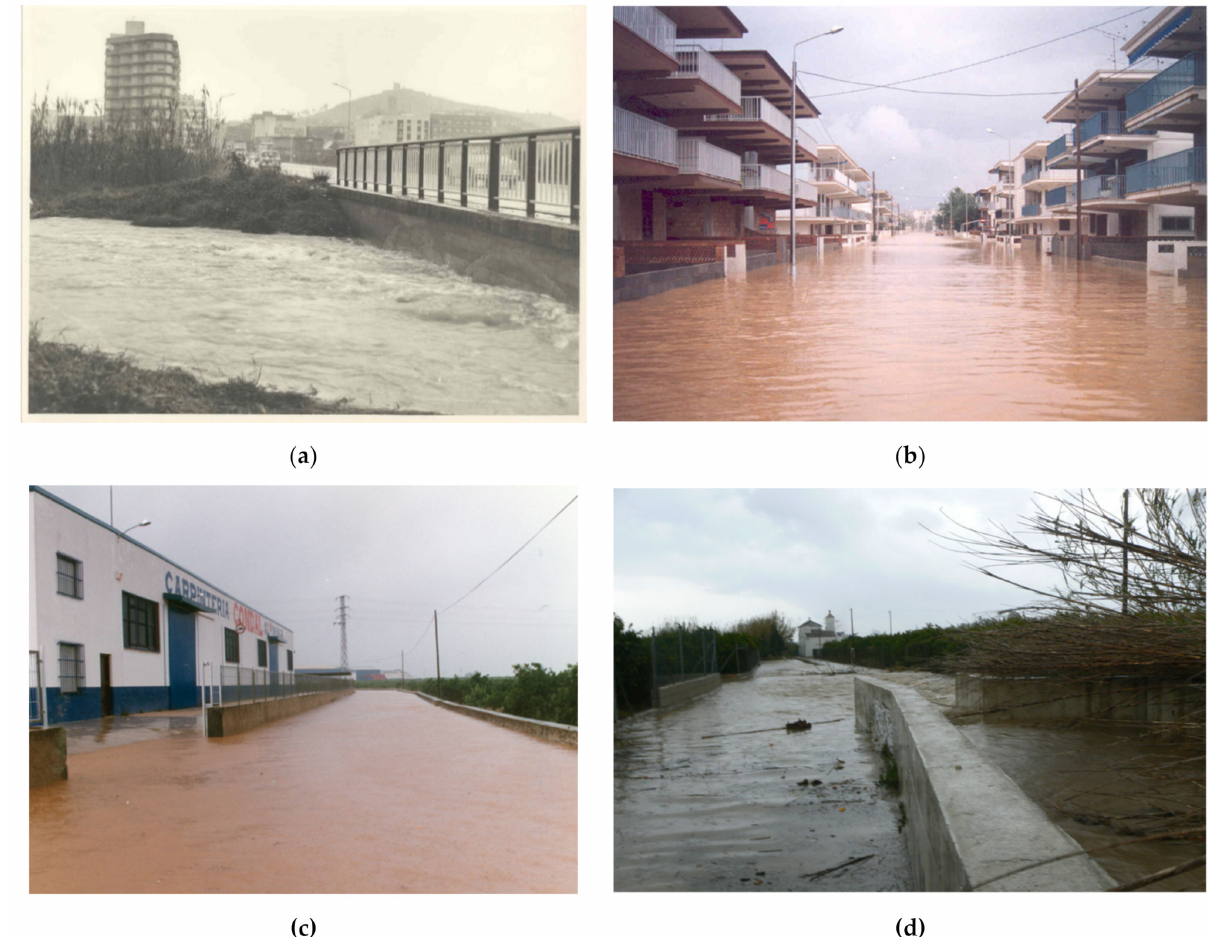
Figure 1. Examples of flooding effects in the area under study (Oliva, Spain): ( a ) flooding in 1972; ( b ) flooding in 1987; ( c ) flooding in 1997; ( d ) flooding in